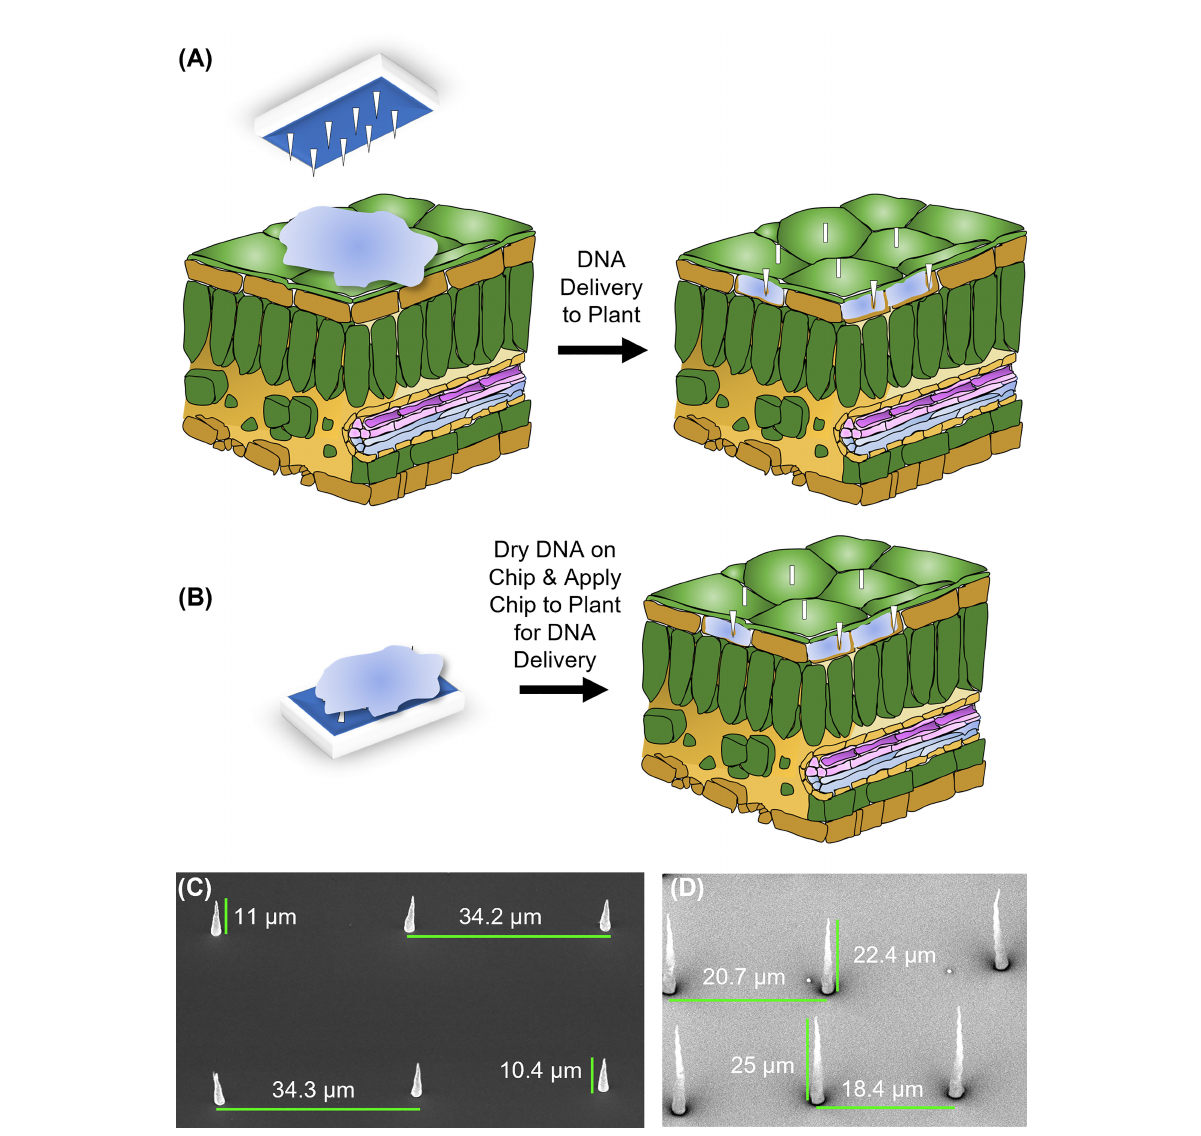
FIGURE 1 Design and application of carbon nano fi bers. (A) On-plant of fi ber delivery. A chip, placed on top of a leaf on which a 1 m L droplet of DNA solution is placed, is gently tapped to push the fi bers into the leaf tissue. The chip is then removed, and nano fi bers typically remain embedded in the tissue. (B) On-chip DNA method of fi ber delivery. Fifteen minutes after a 1 m L drop of DNA is placed on a chip, it is placed on a plant organ surface and tapped with tweezers as in (A) . After tapping, the chip was removed, and nano fi bers were left embedded in the tissue. For both methods, − fi ber controls utilized the fl at ( fi berless) side of the chip. (C) Electron micrograph of VANCFs with ~35 µm pitch, 10-15 µm height, and imaged at a 30° angle. (D) Electron micrograph of VANCFs with ~20µm pitch, 20-30 µm height, and imaged at a 30° angle. Due to the fact that the fi bers were imaged at 30° angle, the apparent heights appear to be smaller than the actual height by a factor of sin(30°)=1/2. Fibers were grown using 200-500 nm e-beam dot sizes and taper to a diameter less than 200 nm. Growth parameters: plasma current 1 amp, C2H2: NH3 = 0.55, 625°C, 10